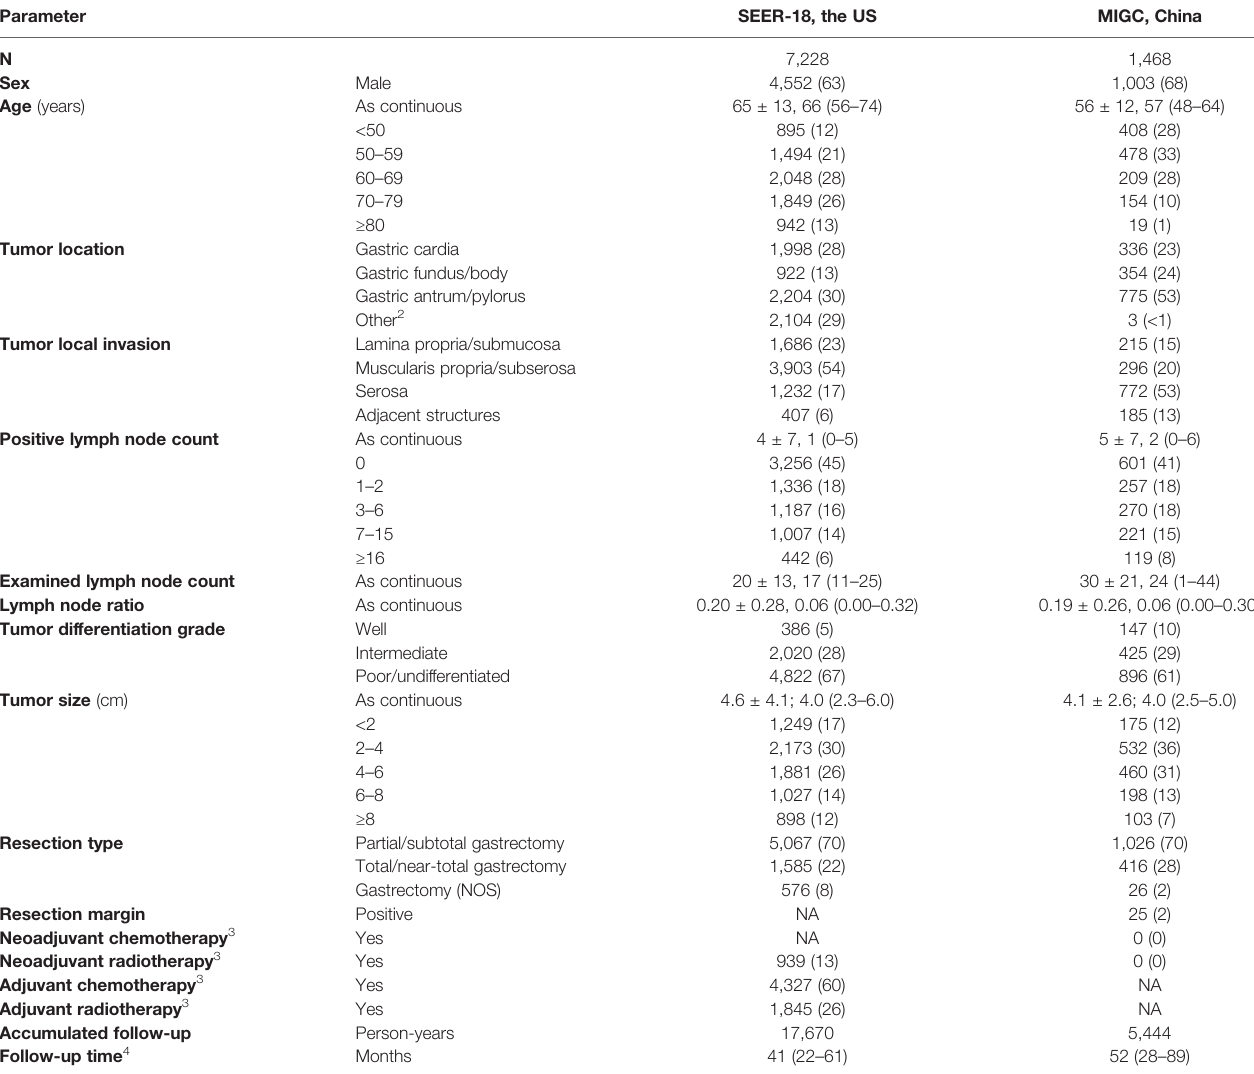
TABLE 1 | Demographic and clinicopathologic characteristics of patients with resected non-metastatic gastric adenocarcinoma and with ≥ 1 examined lymph node, 2010 – 2016 1